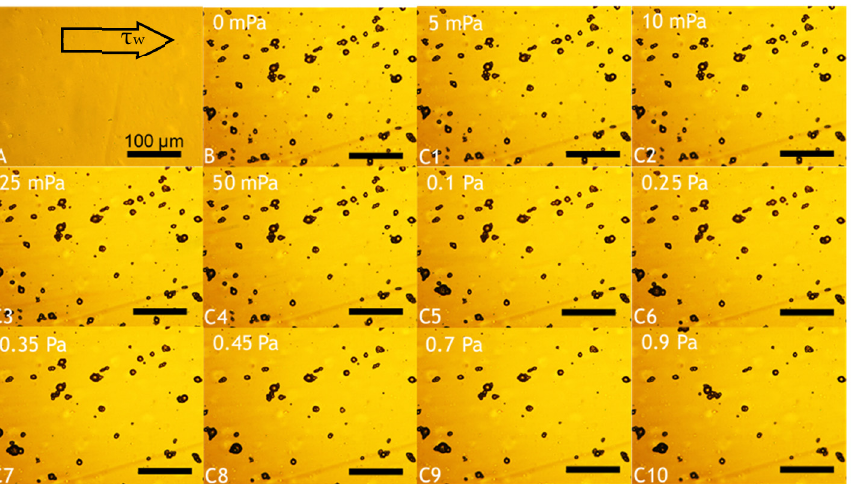
Figure 7. Example of real-time removal of microcapsules adhering to a fully flat PET film at pH 3.2. Background obtained from a blank PET film (baseline) prior to microcapsule inoculation ( A ); deposition of microcapsules following their inoculation and cleaning ( B ); and flushing of microcapsules exposed to increasing shear stress, as follows: 5 mPa ( C1 ), 10 mPa ( C2 ), 25 mPa ( C3 ), 50 mPa ( C4 ), 0.1 Pa ( C5 ), 0.25 Pa ( C6 ), 0.35 Pa ( C7 ), 0.45 Pa ( C8 ), 0.7 Pa ( C9 ), 0.9 Pa ( C10 ). The scale bar displayed in ( A ) is applicable to all images.